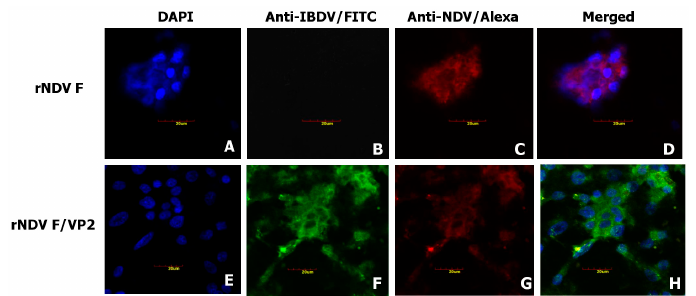
Figure 4. Immunofluorescence analysis of VP2 protein expression in rNDV-F/VP2 virus. Immunofluorescence analysis of VP2 protein expression in rNDV-F/VP2 virus. Confluent monolayers of Vero cells were infected with recombinant viruses rNDV-F/VP2 and rNDV-F at a multiplicity of infection (MOI) of 0.01. The cells were examined by immunofluorescence assay (IFA) with IBDV specific mAb against the VP2 protein (Abcam, USA) and an NDV-specific polyclonal antibody (Abcam, USA), followed by a mixture of the FITC labeled sheep anti-mouse IgG (B,F) and Alexa Fluor 568-labeled goat anti-chicken IgG (C,G). Fluorescence was monitored and photographed using a confocal microscope (Olympus FV 10, USA) at a magnification of 60× under UV light of matching excitation filters for FITC and Alexa Fluor 568 respectively.